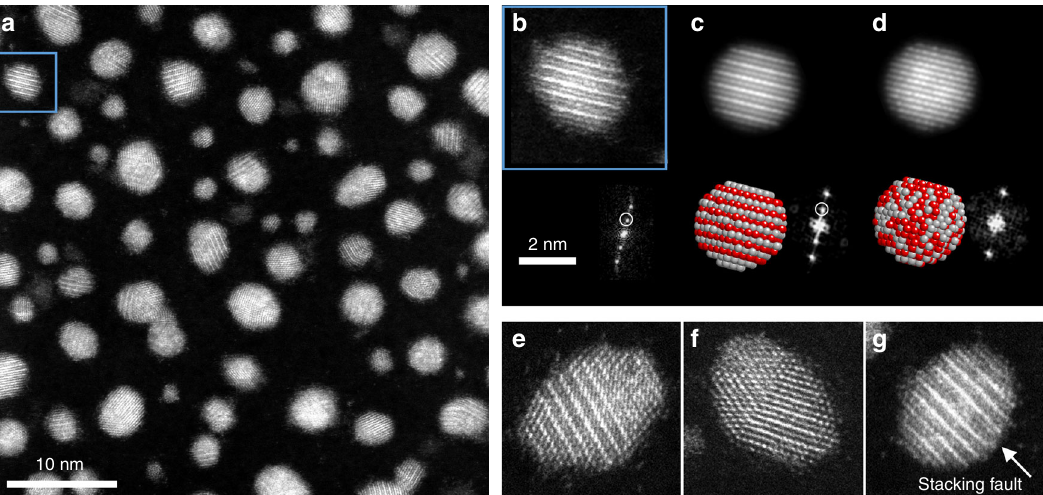
Fig. 2 AgPt NPs after annealing at 400 °C. a STEM-HAADF image; b a zoom on one NP oriented along the [01 (cid:1) 1] zone axis showing the L1 1 phase with alternating planes of Ag and Pt and its corresponding FFT showing the superstructure re fl ections. c , d Simulated STEM-HAADF images along the [01 (cid:1) 1] zone axis for an L1 1 structure and a random solid solution respectively. e – g show multidomains, twin and a stacking fault for L1 1 NPs (Pt atoms are in red and Ag atoms in grey). The scale is the same for b – g . NP nanoparticle, FFT fast Fourier Ttransform, STEM-HAADF high angle annular dark fi eld in